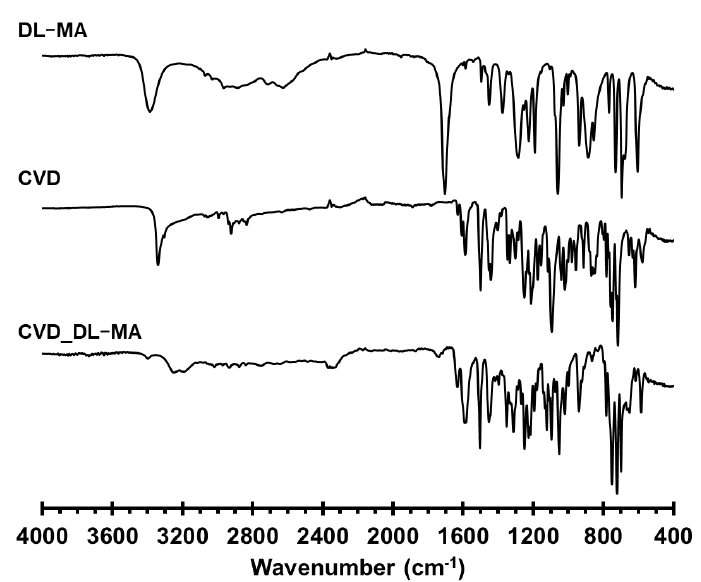
Figure 9. FT-IR spectra of DL-MA, CVD, and CVD_DL-MA.